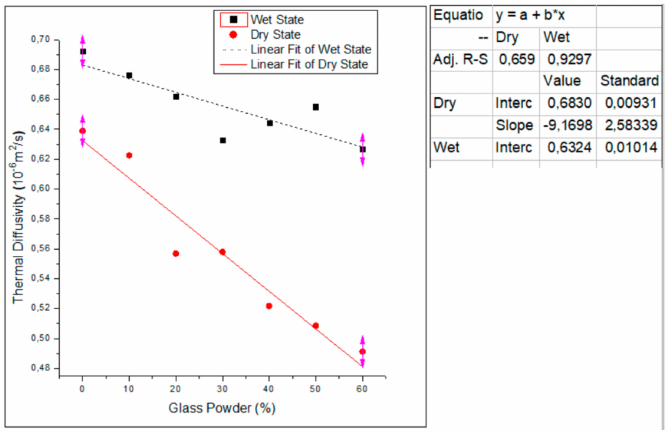
Figure 9. Variation of the measured thermal diffusivity at dry and wet states as a function of the glass powder